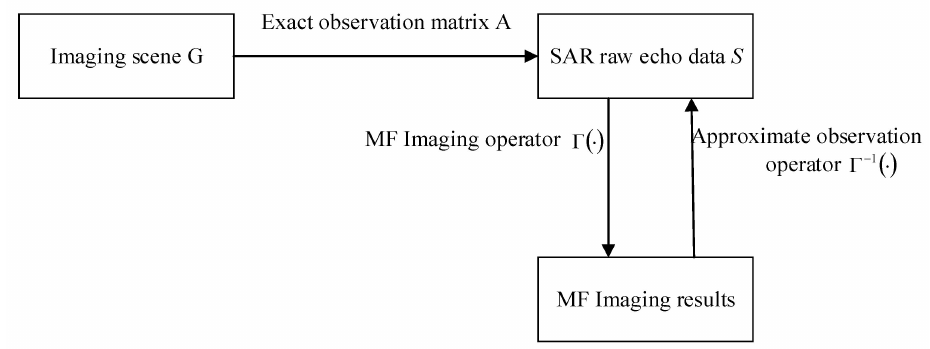
Figure 2. Schematic diagram of an approximate observation